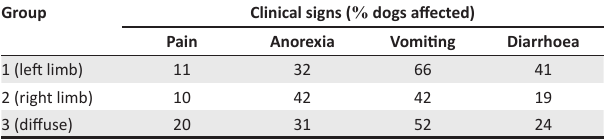
TABLE 1: Percentage of dogs displaying clinical signs according to the region of pancreas affected. Group Clinical signs ( % dogs affected)